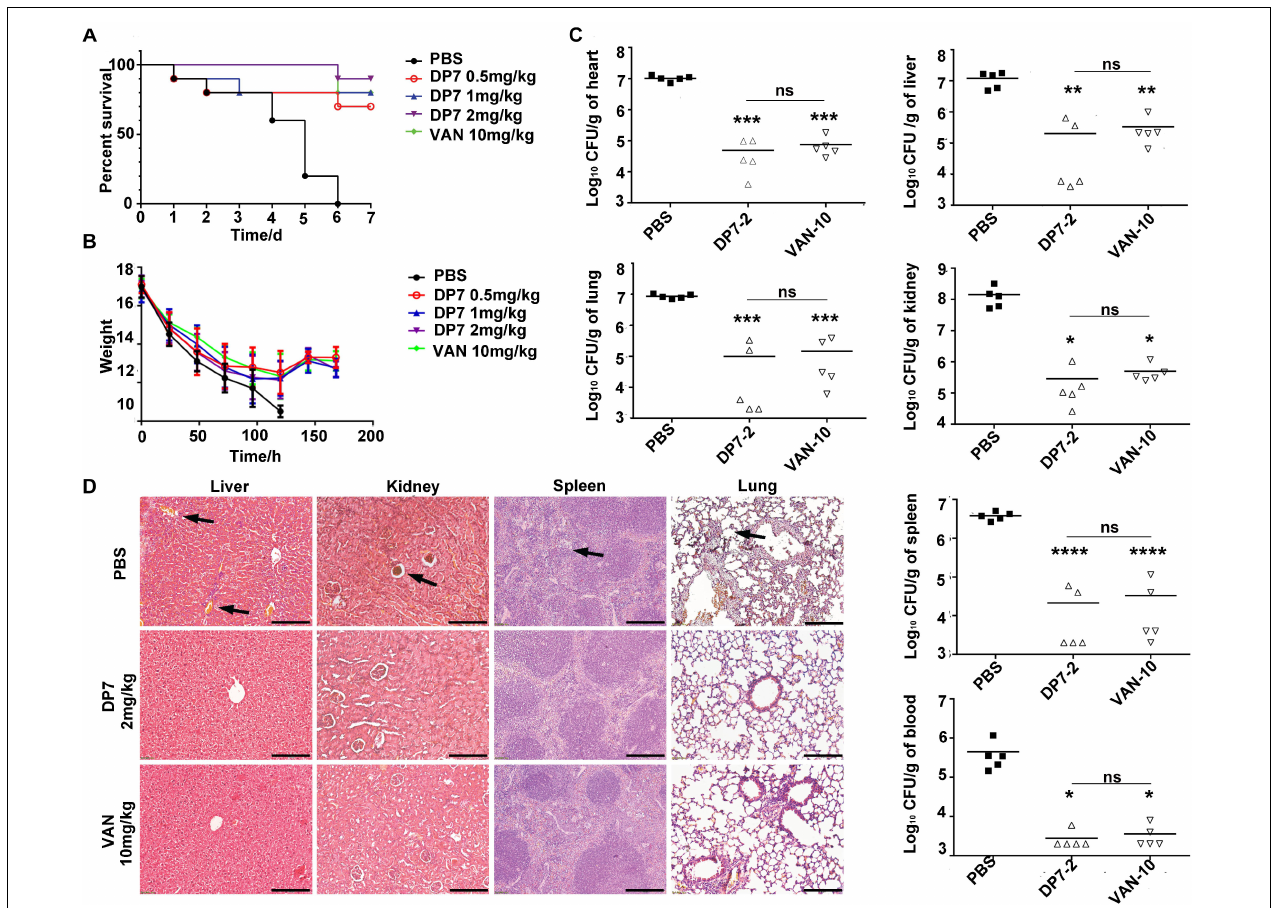
FIGURE 7 | Experimental murine model of blood stream infection. C57 female mice were intravenously injected with 1 × 10 8 CFU/100 µ L ATCC 33591, and antimicrobial drugs were intravenously administered 1 h after injection. The treatments of DP7 doses were 0.5, 1, and 2 mg/kg. PBS and 10 mg/kg of vancomycin acted as negative and positive control, respectively. The bacterial loads at 72 h after infection were counted. Every symbol in Figure 1C represents the viable bacterial counts determined for each mouse, while the average values for each group is represented by the horizontal lines. (A) The survival rate and (B) weight changes after DP7 treatment ( n = 10). (C) CFU counts/g of organs after treatment with 2 mg/kg DP7 or 10 mg/kg vancomycin at 24 h and 72 h ( n = 5). (D) Histology of major organs of mice following lethal MRSA infection. The length of the bars corresponds to 100 µ